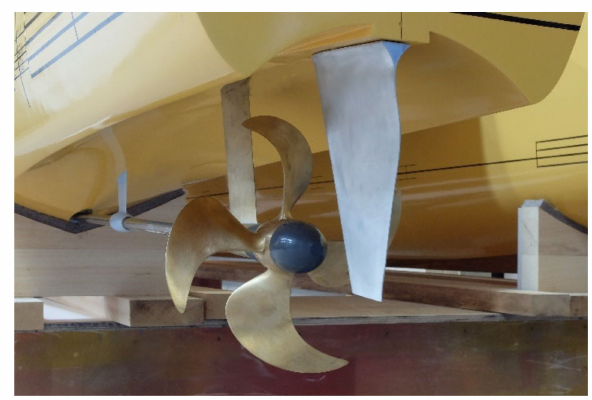
Figure 6. Close-up of the transom stern area of the tested Stavanger model, with fitted propellers, shafts, brackets and rudders